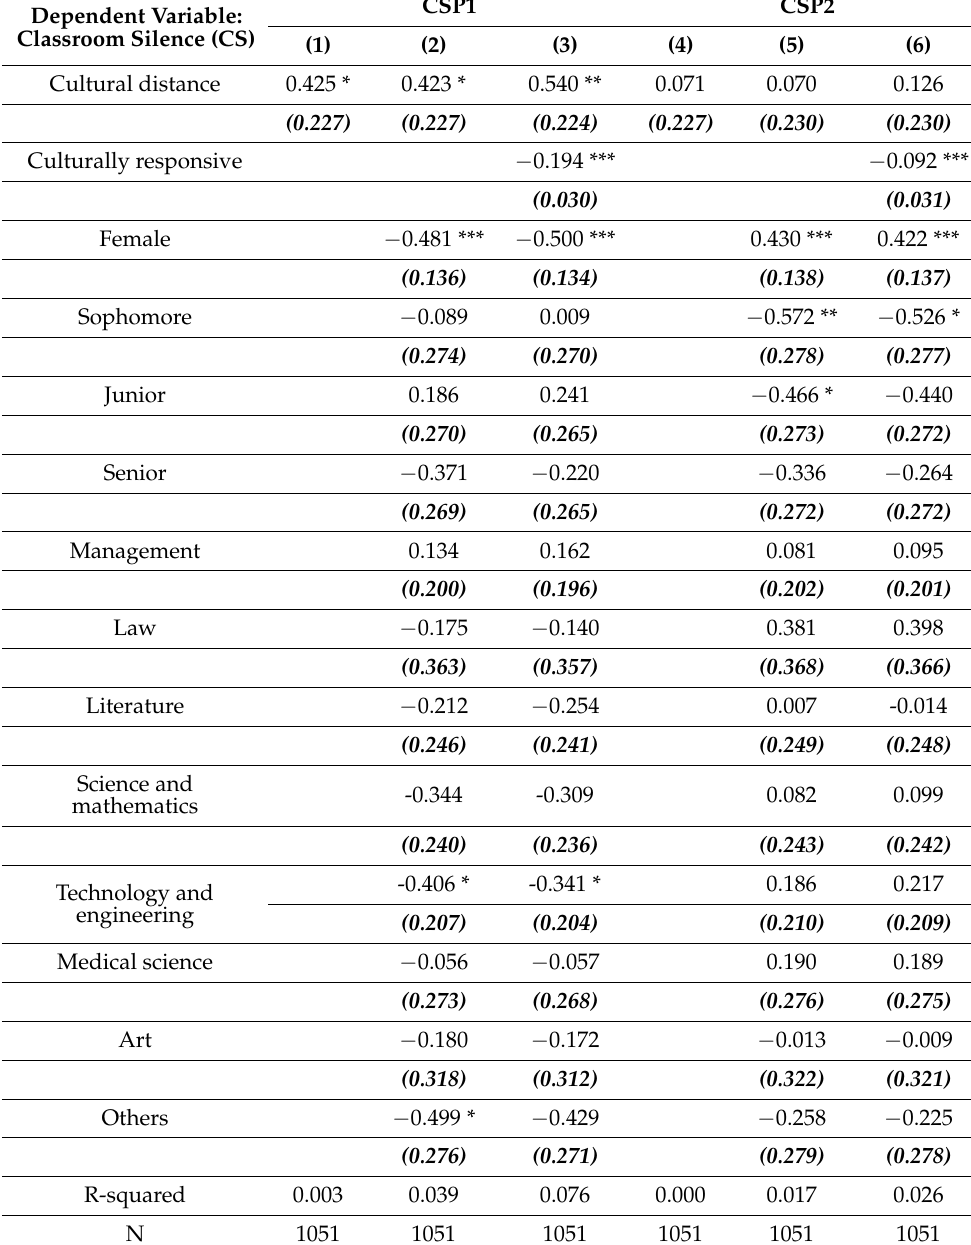
Table 3. Estimated effects of cultural distance and inclusive education on classroom silence by using Equations (2) and